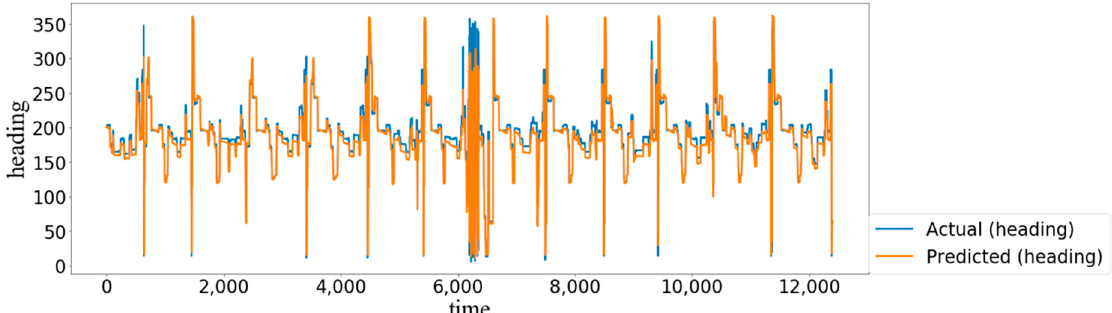
Figure 6. The Prediction of Speed.